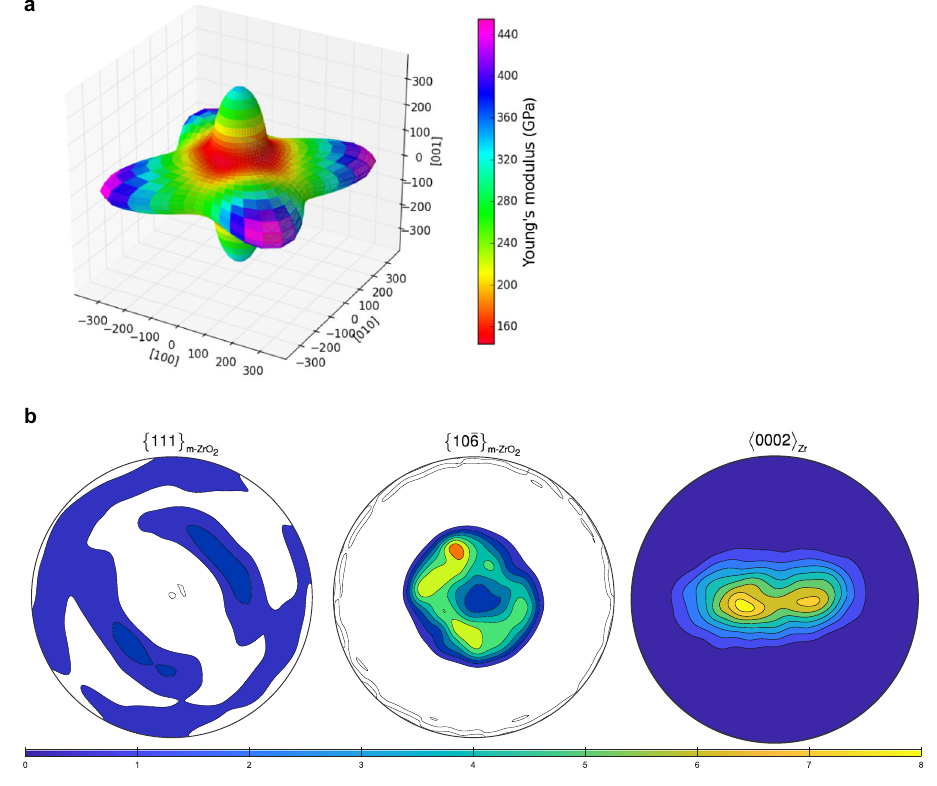
Fig. 9 | Young ’ s modulus of t-ZrO 2 and modelled macrotexture. a Directional dependence of Young ’ s modulus in the body-centred tetragonal ZrO 2 crystal pro- duced using the SC-EMA tool 70 . b Contoured pole fi gures for the f 111 g and f 10 (cid:1) 6 g monoclinic ZrO 2 poles asmodelled using the orientation relationships obtained in